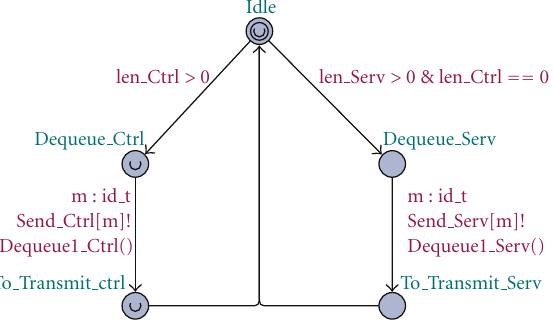
Figure 9: Transmission